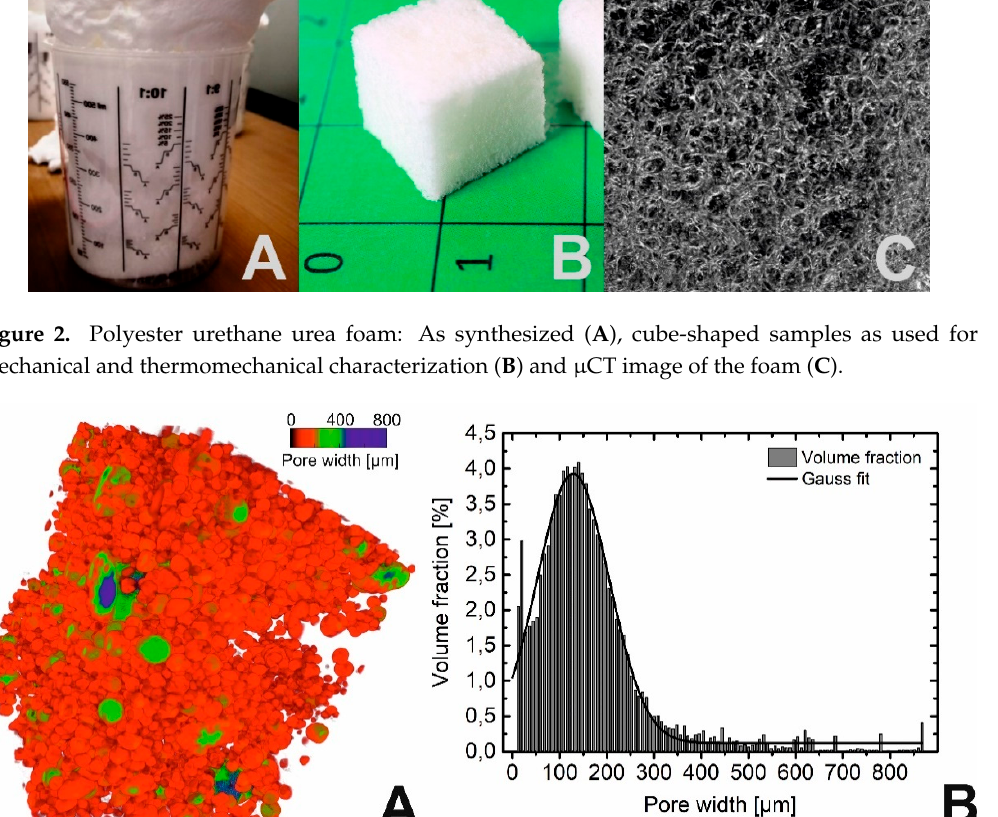
Figure 3. µCT image of PEUU foam after soaking in 1–octanol ( A ), closed cells are colored depending on their diameter) and its evaluation to illustrate the corresponding cell size distribution ( B ).